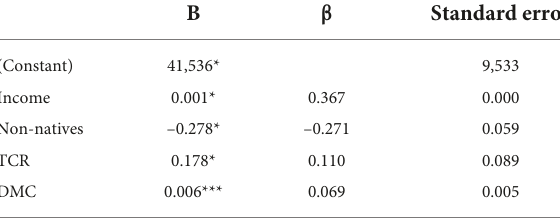
TABLE 3 Regression output for GAS